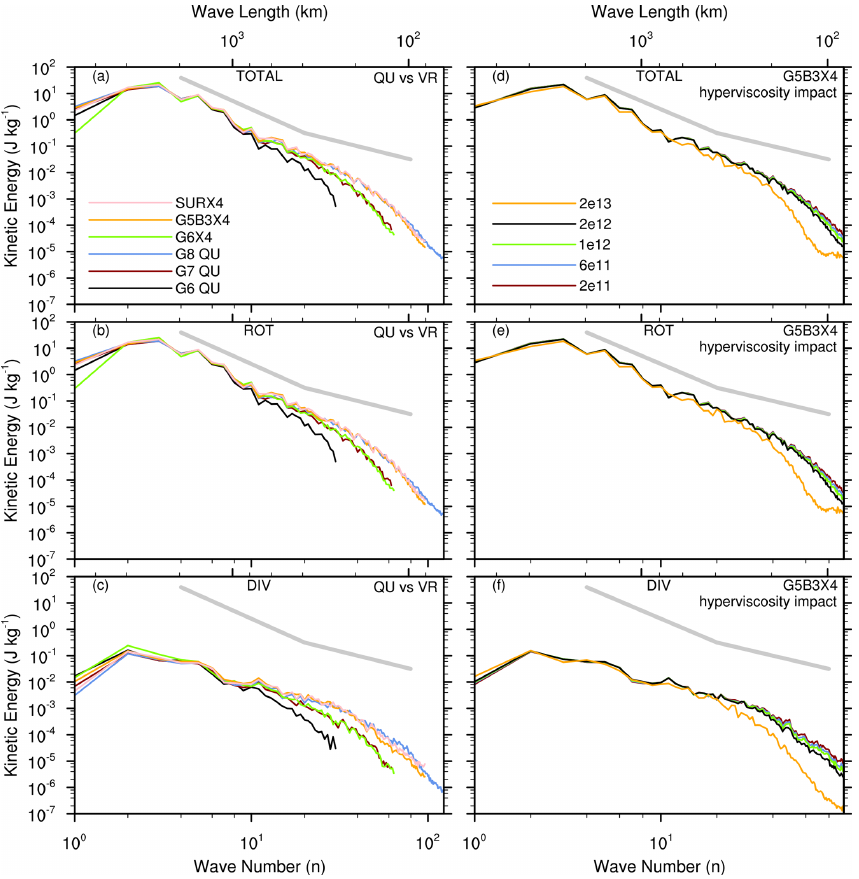
Figure 4. Baroclinic wave. Horizontal regional kinetic energy spectra (unit: Jkg − 1 ) at the model level nearest to 850hPa on day 10: (a) total kinetic energy, (b) the rotational component, and (c) the divergence component. The results of the nonhydrostatic core are shown here, while the results for the hydrostatic core can be found in Fig. S2. The right-hand column (d–f) examines the impact of varying the hyperviscosity coefficient on spectra. The thick gray lines denote the − 3 and − 5 / 3 slopes,